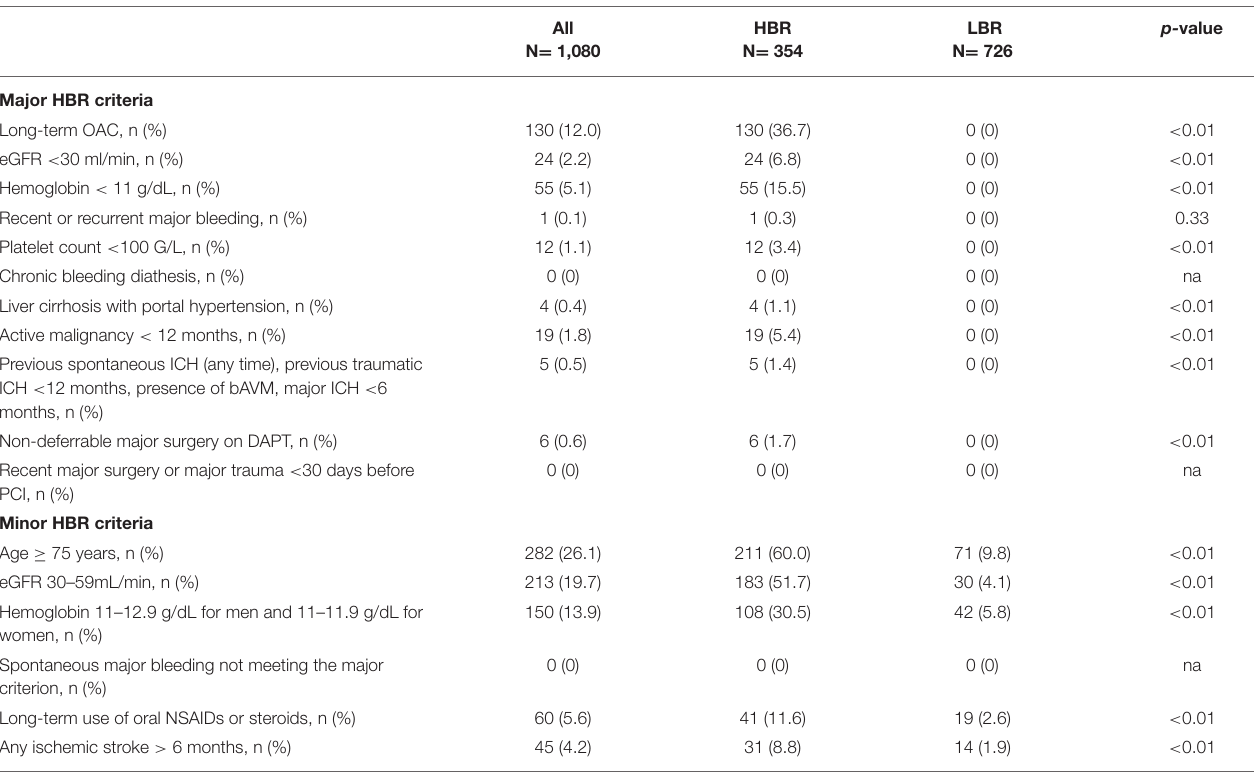
TABLE 1 | Distribution of HBR-ARC